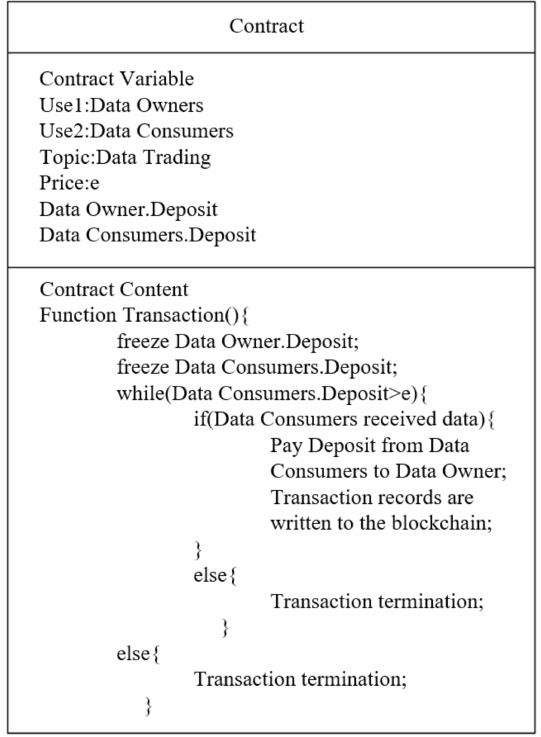
Figure 5. Smart contract